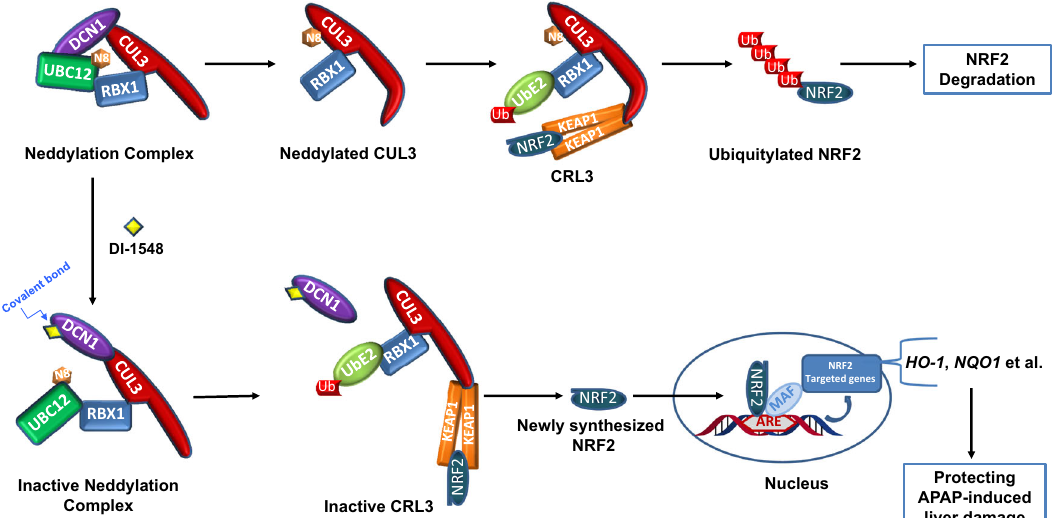
Fig. 8 Proposed mechanism of action of covalent DCN1 inhibitor DI-1548 for its protection of APAP-induced liver damage via selective inhibition of cullin 3 neddylation. DI-1548 covalently binds to DCN1 and disrupts the interaction of DCN1 – UBC12 and causes the collapse of neddylation complex. The resultant inactive CRL3 leads to the accumulation of NRF2 which upregulates its targeted genes and effectively protects mice from acetaminophen-induced liver